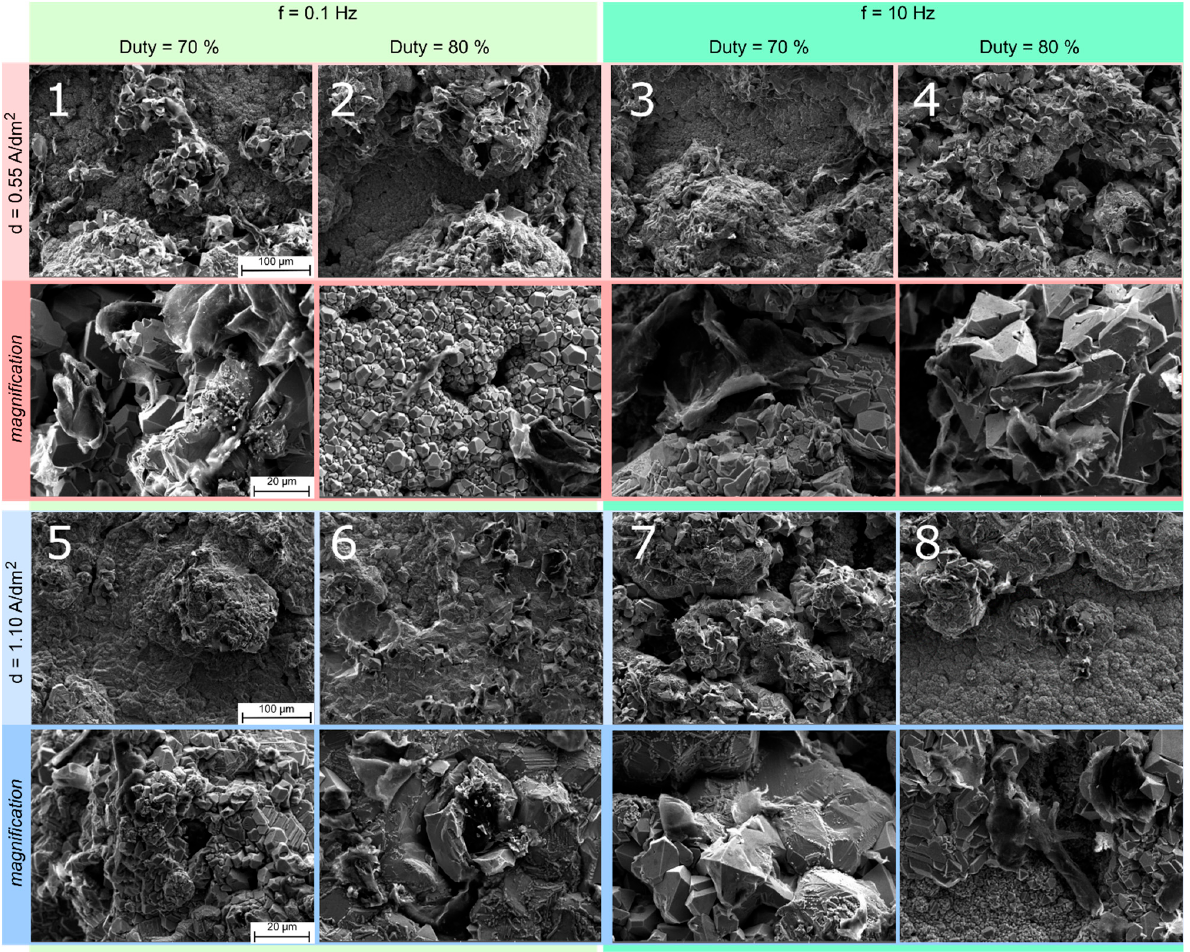
Figure 4. SEM images of the Cu-GnP composite coatings: the number in white represents the test scenario (see Table 6).